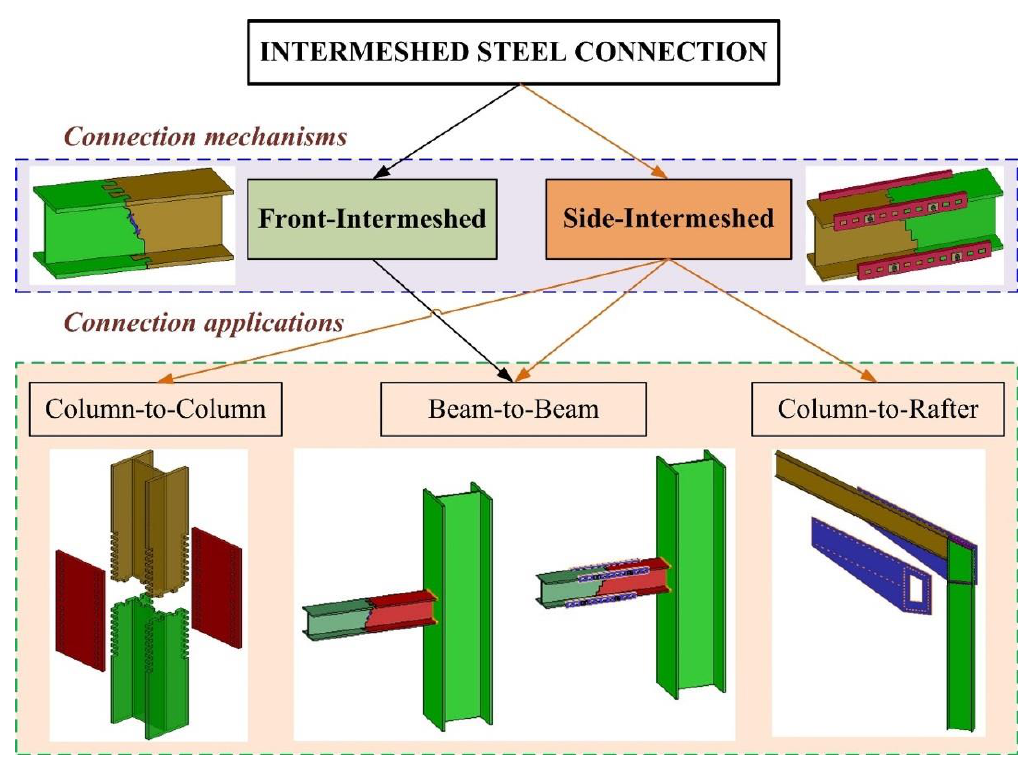
Figure 2. Some intermeshed steel connection configurations.